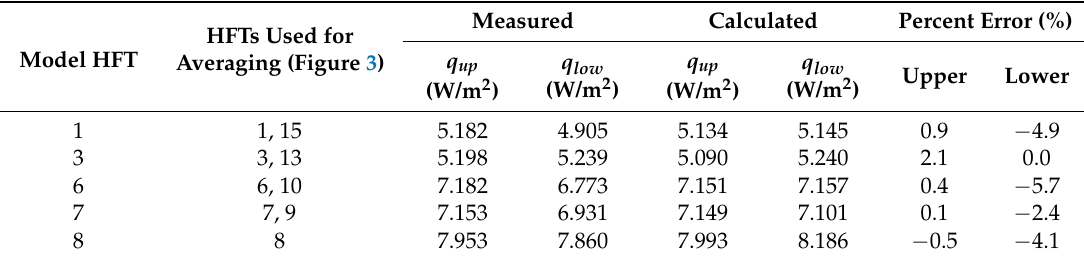
Table 4. Comparison of measured and calculated heat fluxes through composite ‘d’.